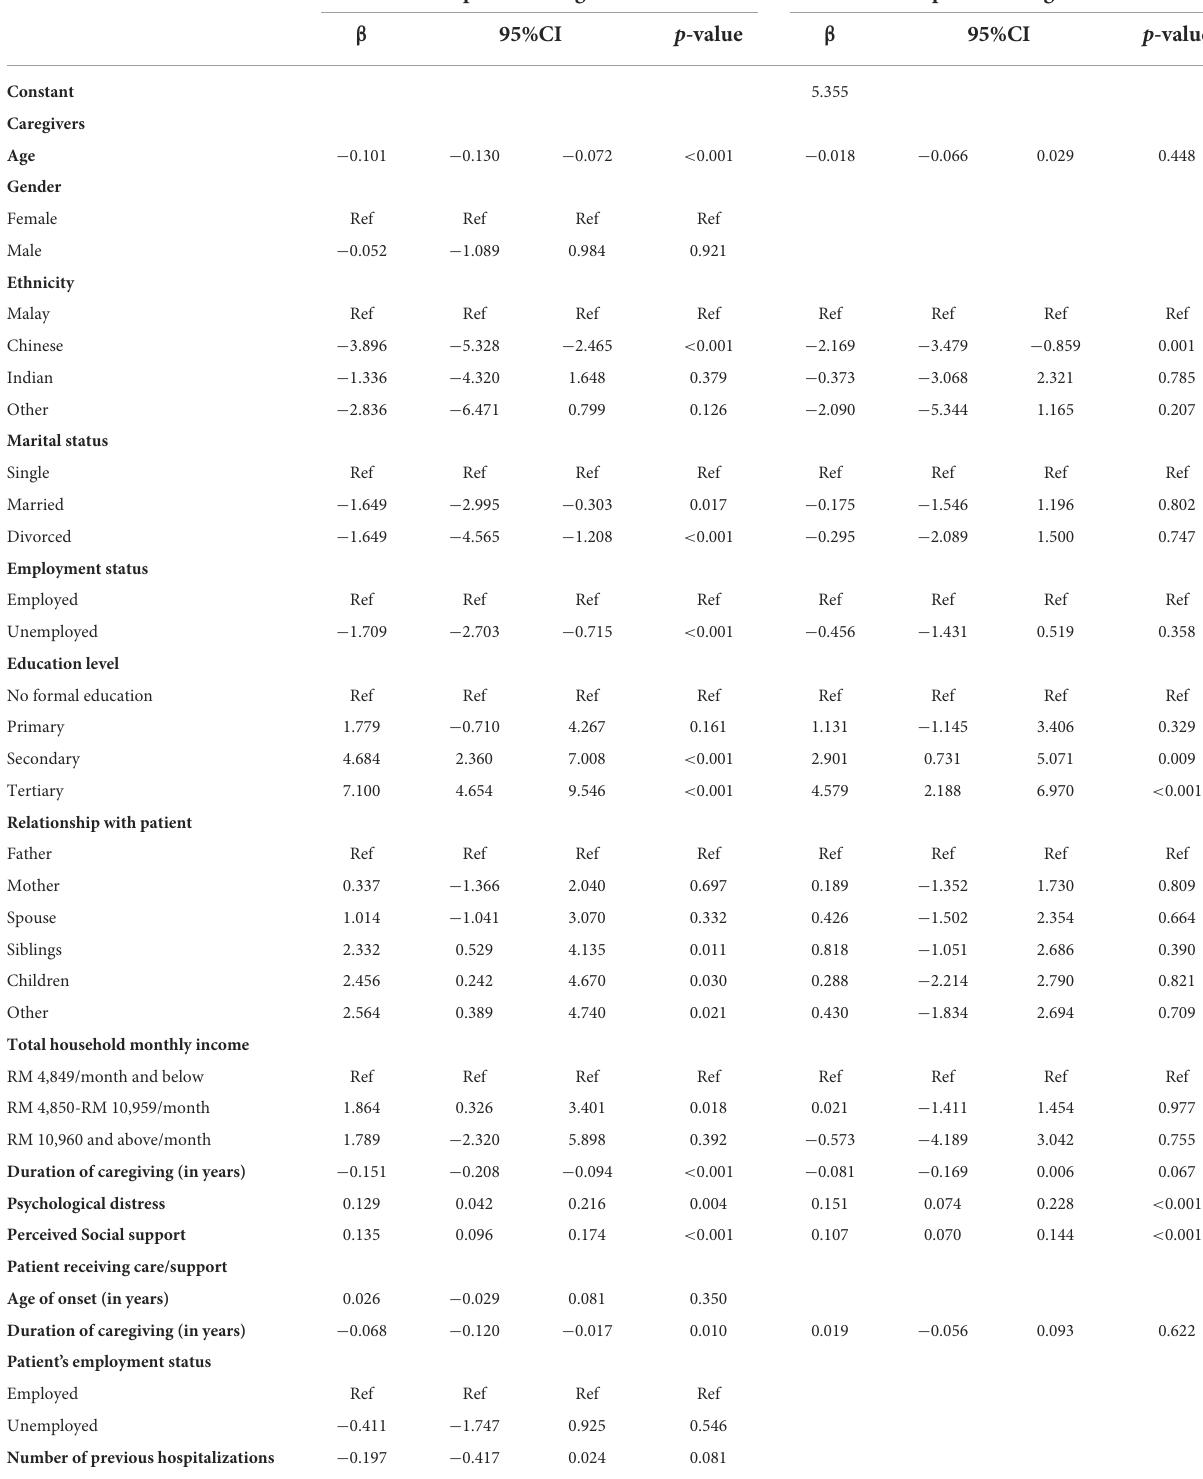
TABLE 4 Factors associated with problem focus coping strategies among caregivers of patients with schizophrenia. Factors Simple linear